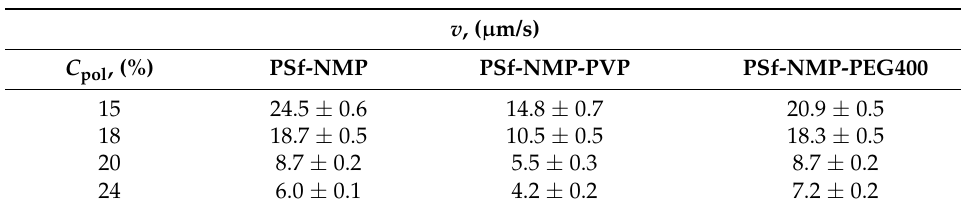
Table 2. The precipitation rate of PSf in NMP casting solutions. I—PSf-NMP; II—PSf-NMP-PVP; III—PSf-NMP-PEG.